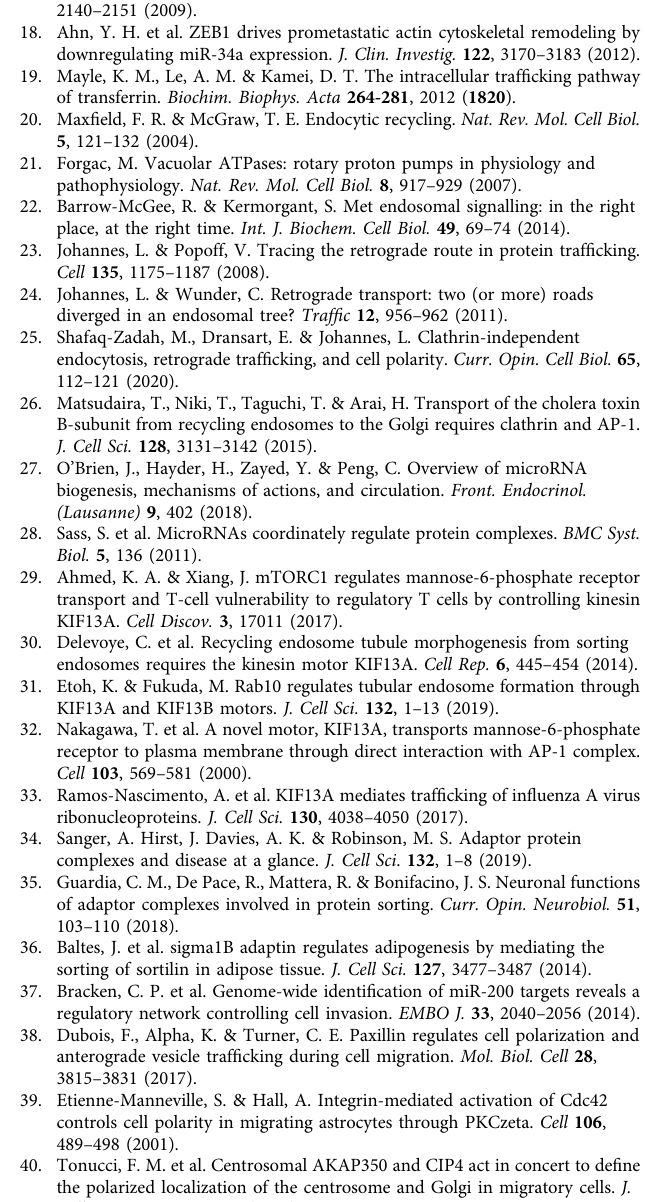
Fig. 8 ZEB1-dependent vesicular traf fi cking facilitates the establishment of a front-rear polarity axis. a , b Correlation of peripheral Tfn signal intensity with metastatic capacity ( a ) and Golgi area ( b ) in murine LUAD cell lines fi xed 10 min after initiating endocytosis. c Percentages of cells on the wound front with Golgi organelles polarized toward the leading edge. n = 5 independent experiments. d Percentages of cells on the wound front with FAs polarized toward the leading edge. n = 10 independent experiments. e Merged confocal micrographs of siRNA-transfected 344SQ cells stained with anti-phospho- paxillin (p-Pxn) antibody to detect FAs. The direction of cell migration on advancing front (arrow). Scale bars: 20 µ m. f , g Plot showing average FA number ( f ) ( n = 25 cells from 3 independent experiments) and size g ( n = 23 cells from 3 independent experiments) per cell in the siRNA-transfected 344SQ cells ( e ). h , i Cell speed and directionality for each cell (dot) measured from automated tracking of 393P_ZEB1 cells seeded at low density on the fi bronectin- coated surface and transfected with siRNAs against KIF13A ( h ), AP1S2 ( h ), or ITG α 5 ( i ). h n = 180 cells (speed) or 143 cells (directionality) from 3 independent experiments. i n = 250 cells (speed) or 225 cells (directionality) from 3 independent experiments. j , k Migration and invasion assays in Boyden chambers for 344SQ cells transfected with KIF13A ( j ) or ITG α 5 ( k ) siRNAs. n = 3 independent experiments. l Invasive activities of siRNA- transfected 393P_ZEB1 cells seeded as multicellular aggregates in collagen gels. Invasions scored as single-cell or collectively invasive protrusions. n = 14 aggregates from 3 independent experiments. Scale bars: 100 µ m. m Model illustrating that ZEB1 activates KIF13A-dependent endocytic recycling to promote front-rear axis polarity and motility. Data are presented as mean values ± SEM, or as mean values ± SD ( j – l ); P values, two-tailed Student ’ s t test, or one-way ANOVA ( c , d , f – l ). R values, Spearman ( a , b